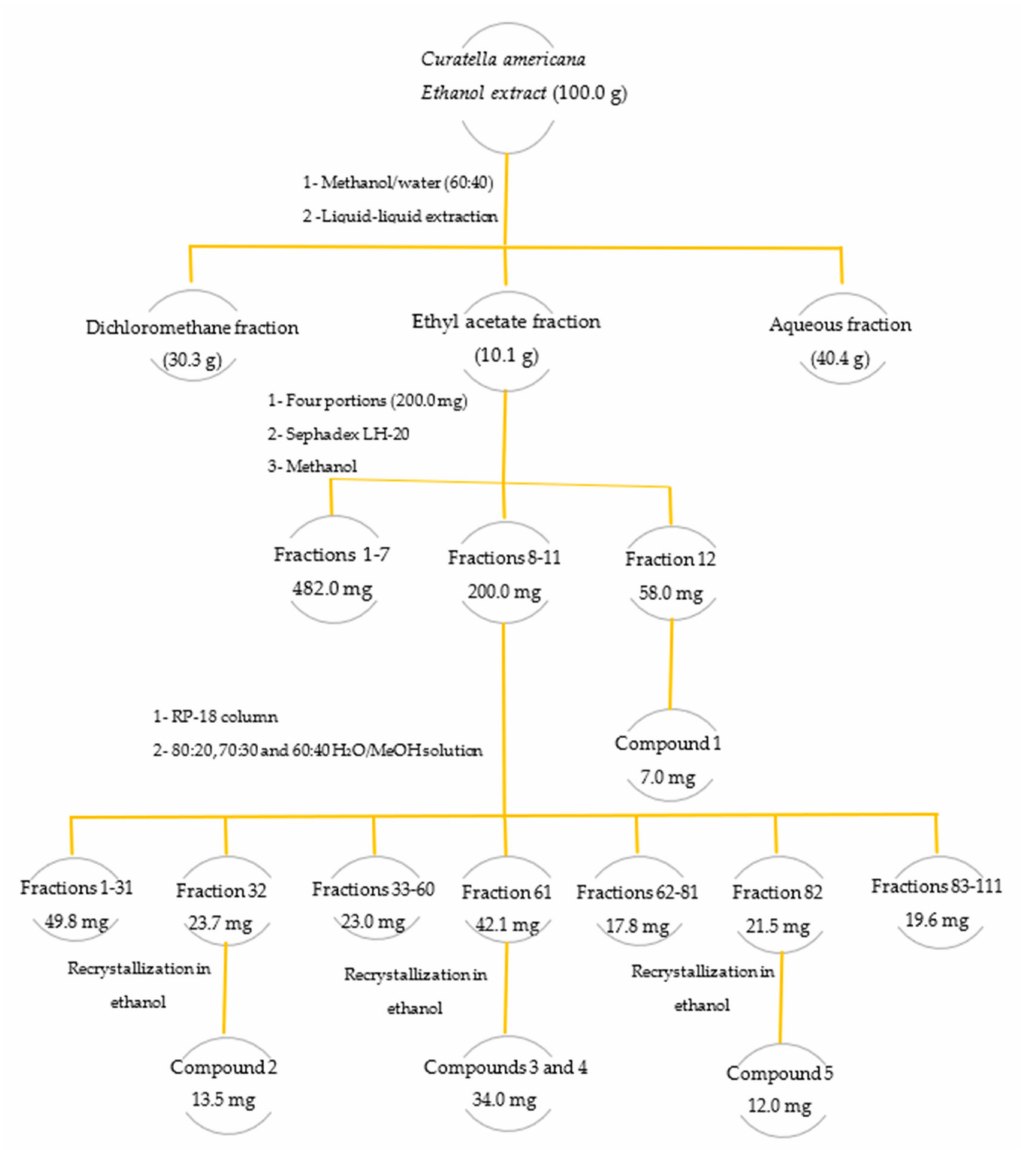
Figure 5. Fractionation of the ethanolic extract of leaves of the species Curatella americana . Fractions 8 to 11 with a similar profile on TLC were pooled (totaling 200.0 mg) and subjected to fractionation by chromatography on a reversed-phase silica gel octadecylsilane column (Merck ® , Kenilworth, NJ, USA, RP-18 column, 4 g, ø 10 µ m; eluted with an